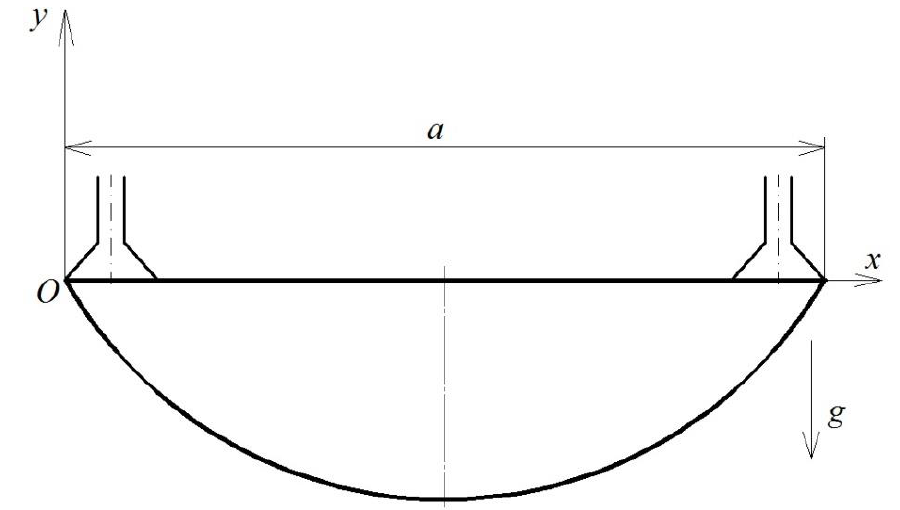
Figure 2. Scheme of slightly opened flexible container neck sagging.